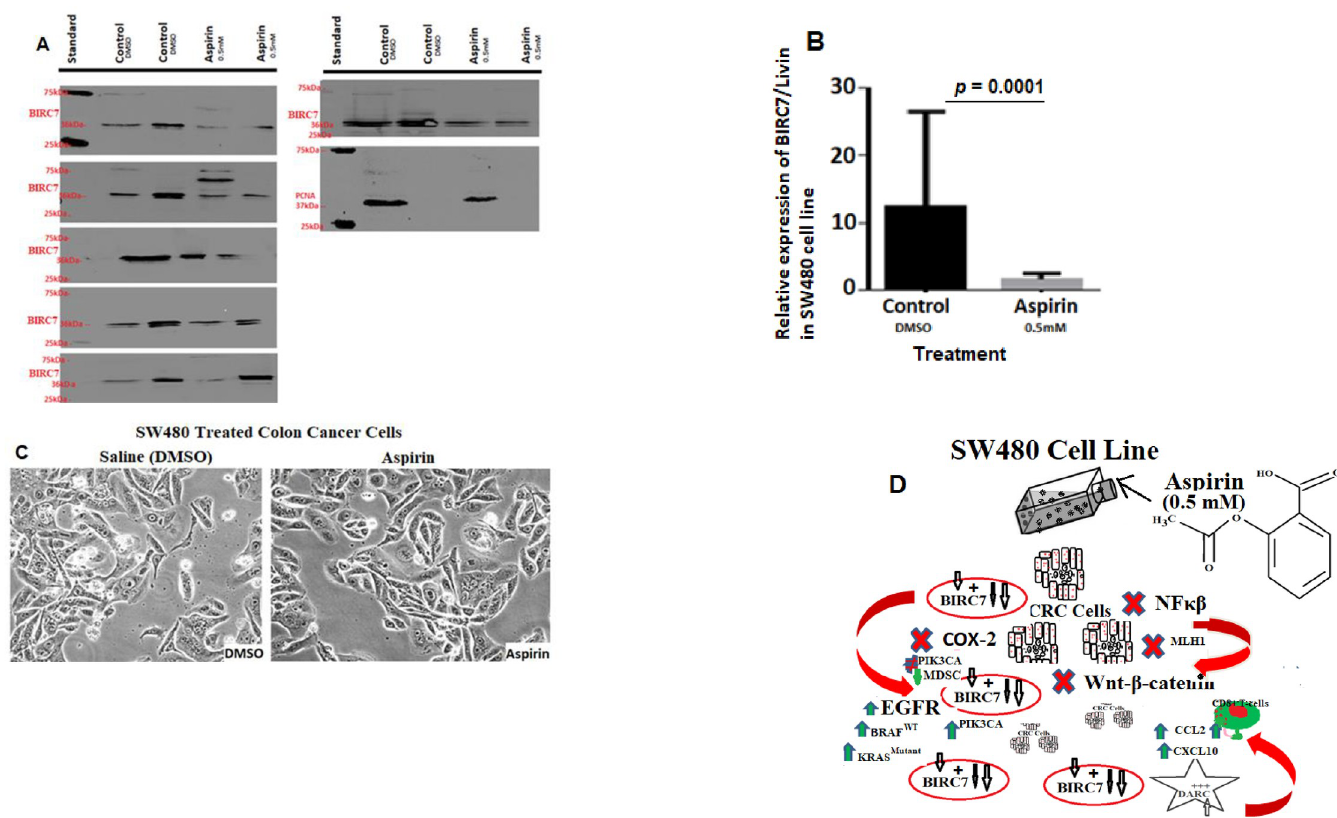
Fig 2. Effect of aspirin treatment on BIRC7/Livin expression in DNA mismatch repair proficient, p53 mutant SW480 cell line in vitro . A Is an Immunoblot showing effect of the 0.5 mM aspirin treatment on the SW480 compared to DMSO. PCNA was used as loading control. B, Quantitative analysis of BIRC7/Livin showing H score of the pattern of expression of the protein. C) SW480 cell line treated with 0.5 mM DMSO (vehicle control) and also with 0.5 mM aspirin for 24 hours (right). D) Describes the molecular pathway of aspirin metabolism, transport and target mechanises in colorectal cancer. This include inhibition of COX2, NF-kappaB and Wnt- B-Catenin signalling pathways for modulating BIRC7, DARC, PD-L1, Annexin V, PMS2, EGFR, BRAF, KRAS, PIK3CA, Bcl2, and p53 functions.